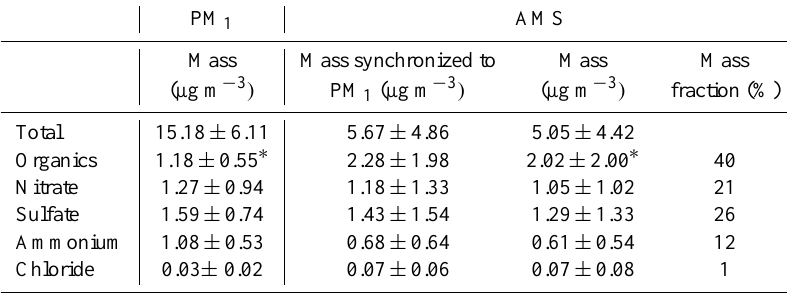
Table 1. Summary of the mean concentrations ( ± 1 standard deviation) measured on PM 1 filter samples and AMS (using the same sampling time and days than PM 1 (Mass synchronized to PM 1 ) and for the entire campaign). PM 1 AMS